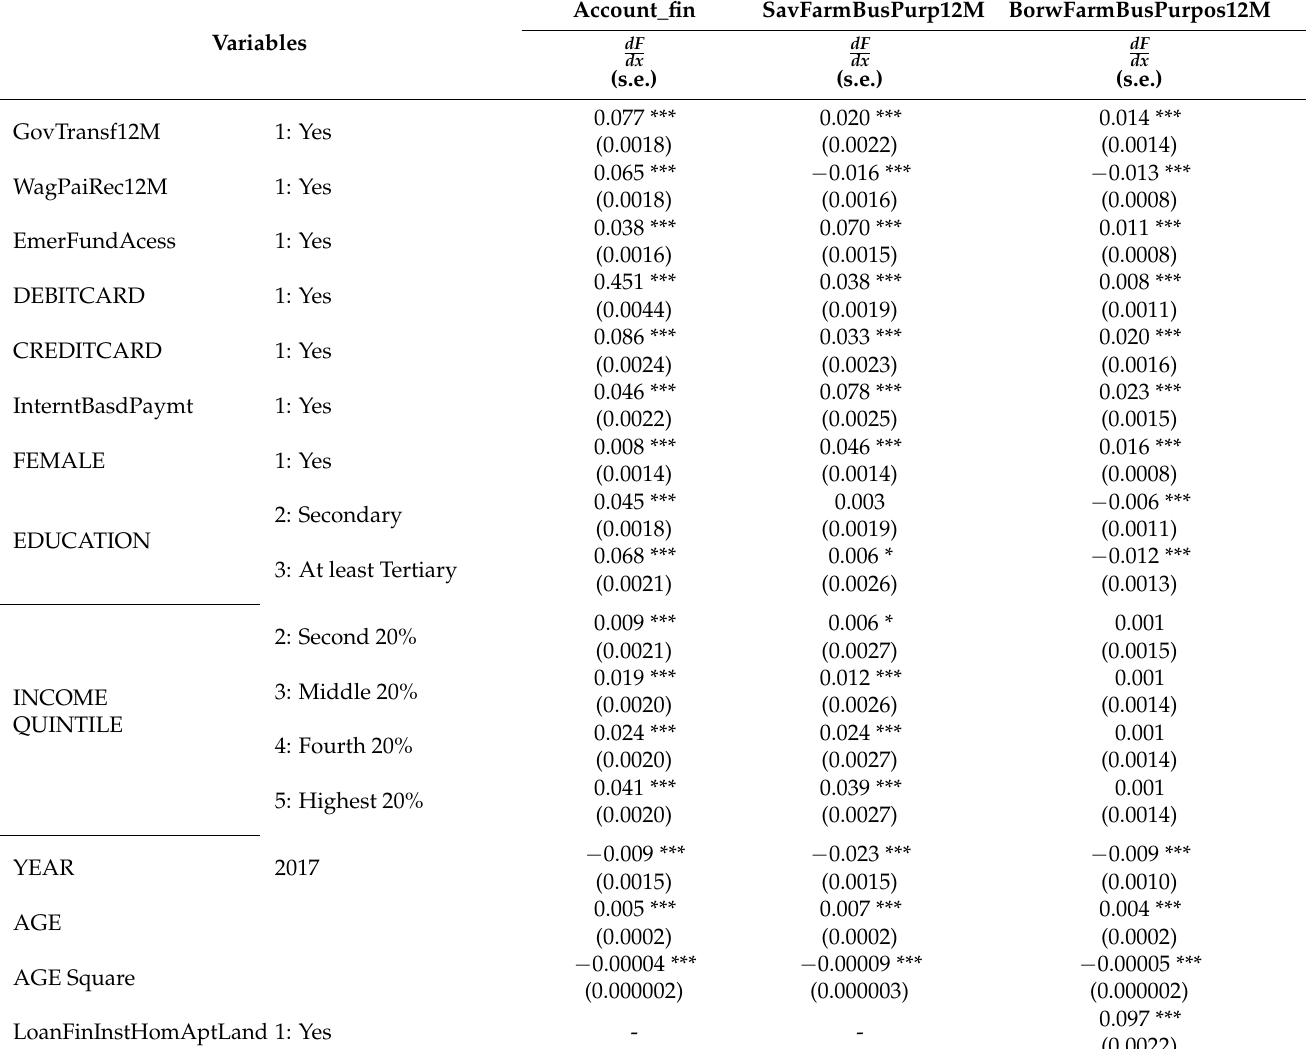
Table A7. Marginal Effects of Demand side determinants of formal account ownership, saving and borrowing for Entrepreneurial (Farming or Business)